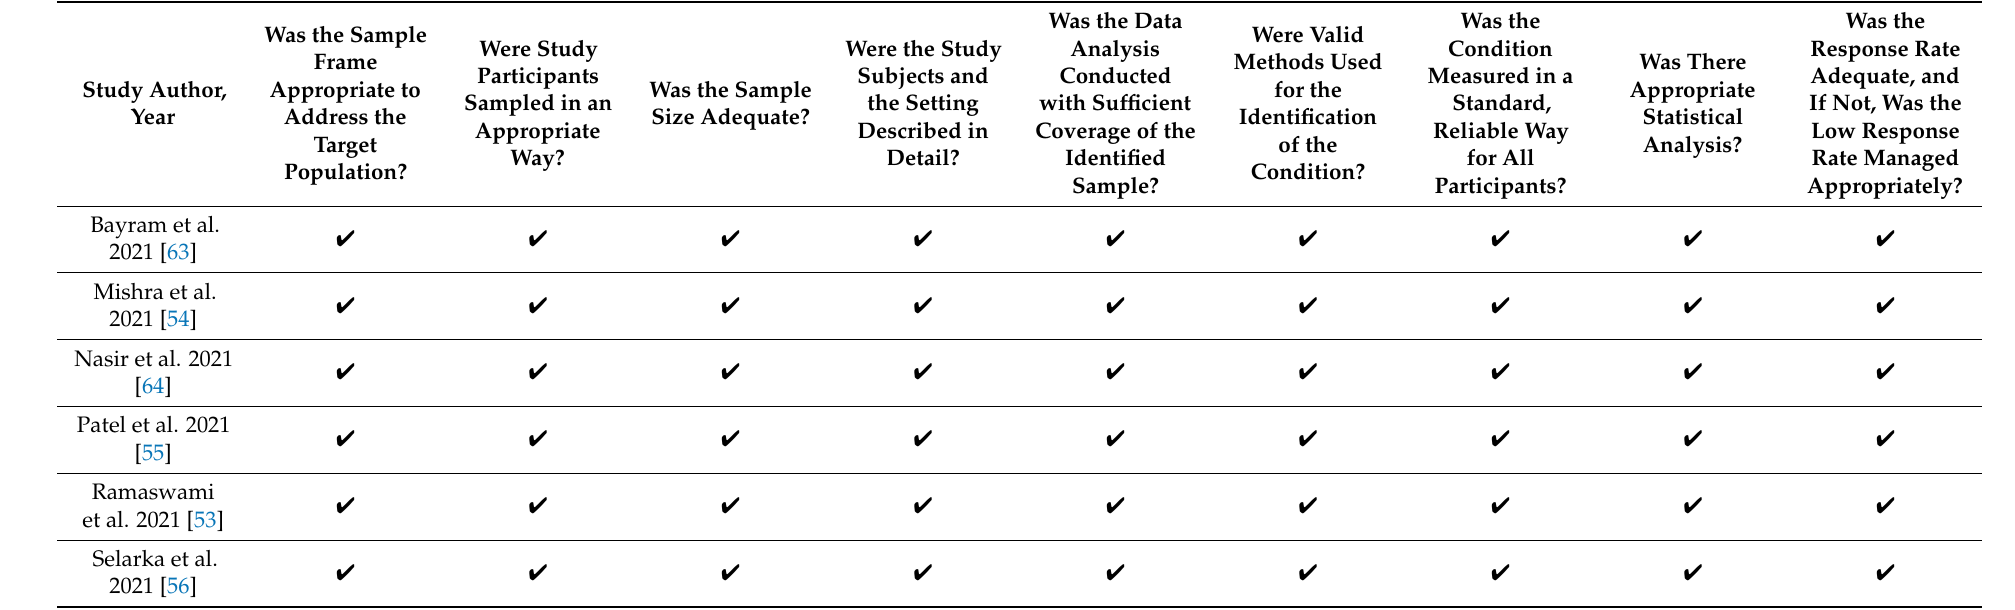
Table 2. Risk of Bias Assessment Using the JBI tool for Cross-sectional Studies.